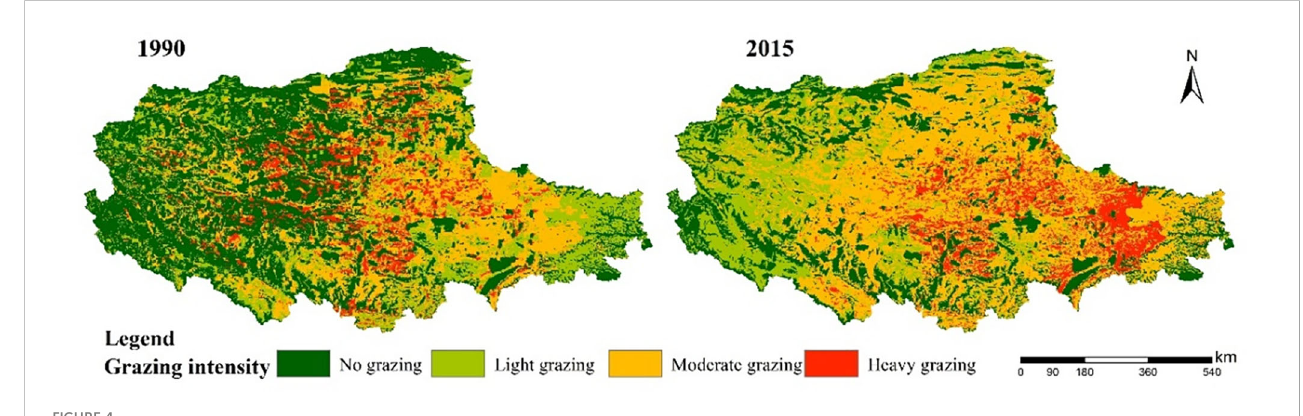
FIGURE 4 Grazing intensity in 1990 and 2015.